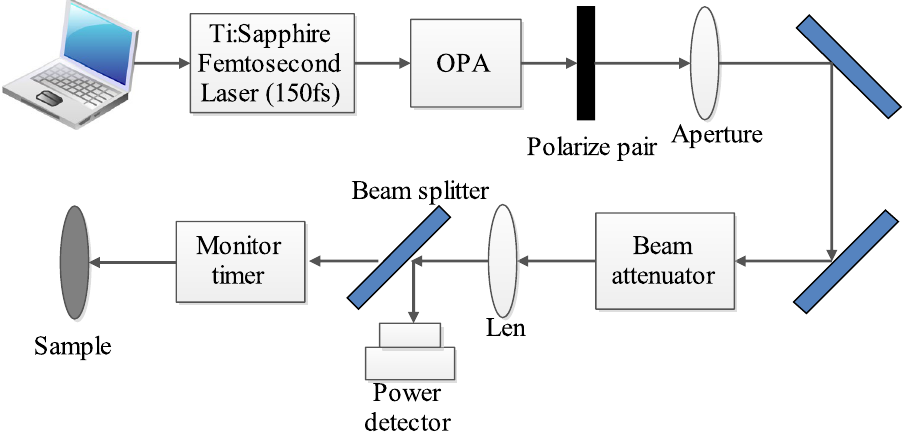
Figure 9. Schematic of the experimental configuration (drawn by the software of Edraw